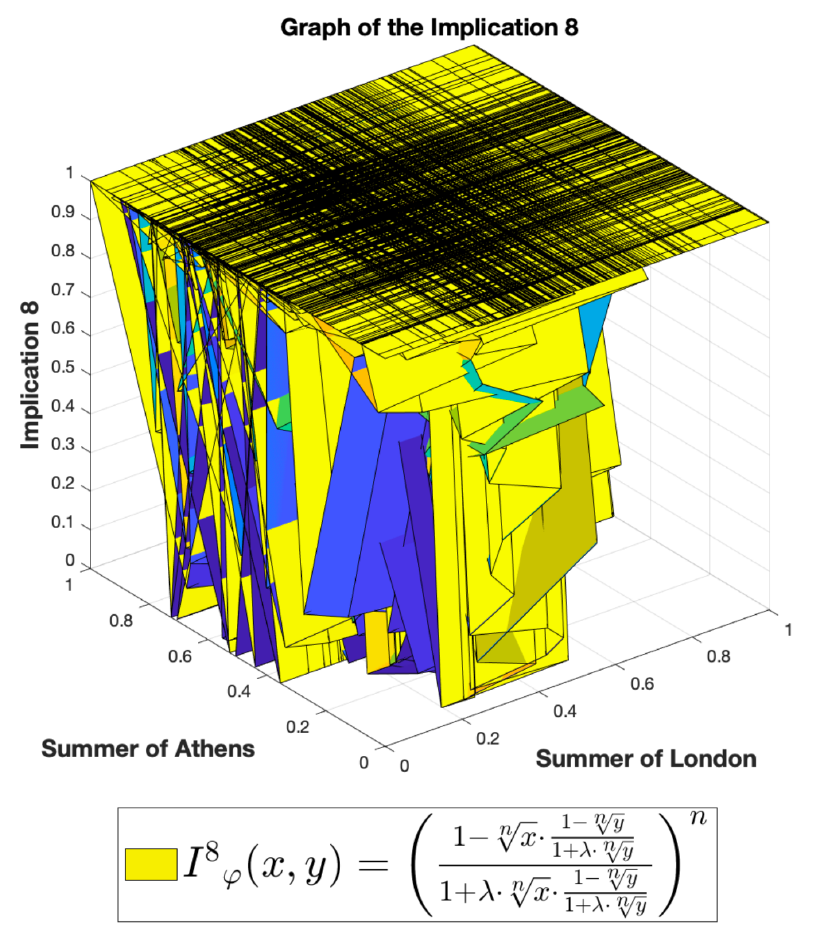
Figure 10. Graph of the Implication